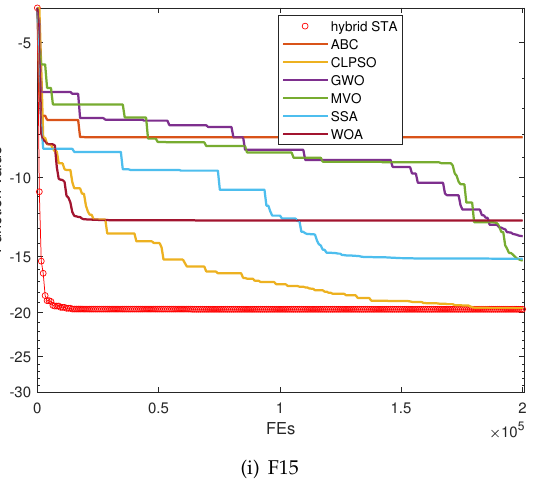
Figure 6. Average convergence curves of different metaheuristic methods on benchmark functions with D = 20.